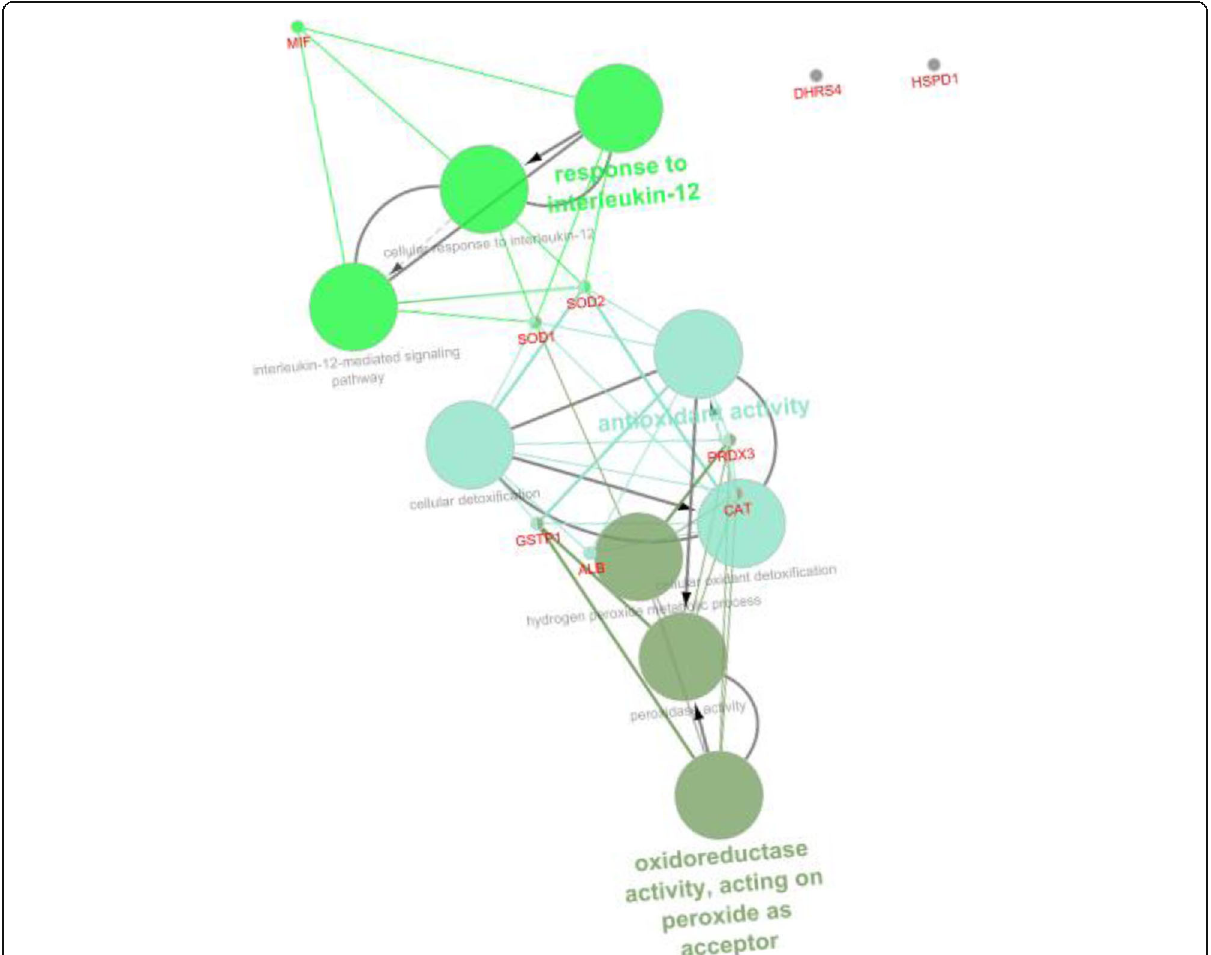
Fig. 5 Pathway analysis of the inter-protein interactions of the differentially expressed proteins associated with oxidative stress protection in the liver of the supplemented rabbits using Cluego App of the Cytoscape 8.3.1. The pathway analysis showed that the specific oxidative stress protection were the functions of these proteins where they function in oxidoreductase activity, acting on peroxide as acceptor, intracellular antioxidant activity, cellular oxidant detoxification, hydrogen peroxide metabolic process, cellular detoxification, interleukin-12 mediated pathways and response to interleukin-12. The supplemented group were provided with 500 mg Chlorella vulgaris biomass per kg body weight daily throughout the experimental